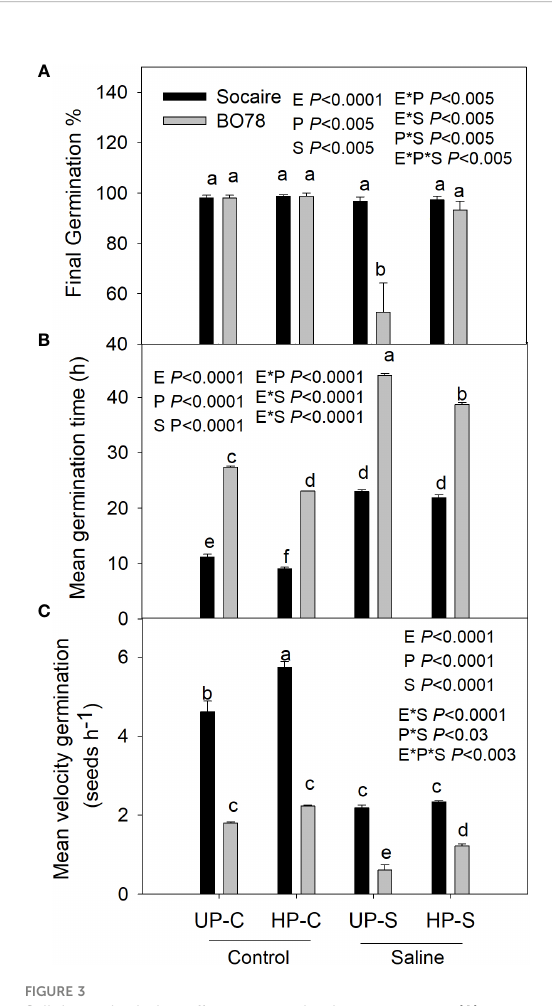
FIGURE 3 Salinity and priming effect on germination percentage (A) , mean germination time (B) , and mean velocity germination (C) of Socaire and BO78 ecotypes of quinoa seeds. Error bars show mean ± SE ( n = 12). Different letters indicate signi fi cant differences between ecotypes (E, Socaire or BO78), priming (P, UP or HP), and treatment (T, C, or S) using three-way ANOVA. Tukey HSD was used as a post-hoc test ( p < 0.05). FIGURE 4